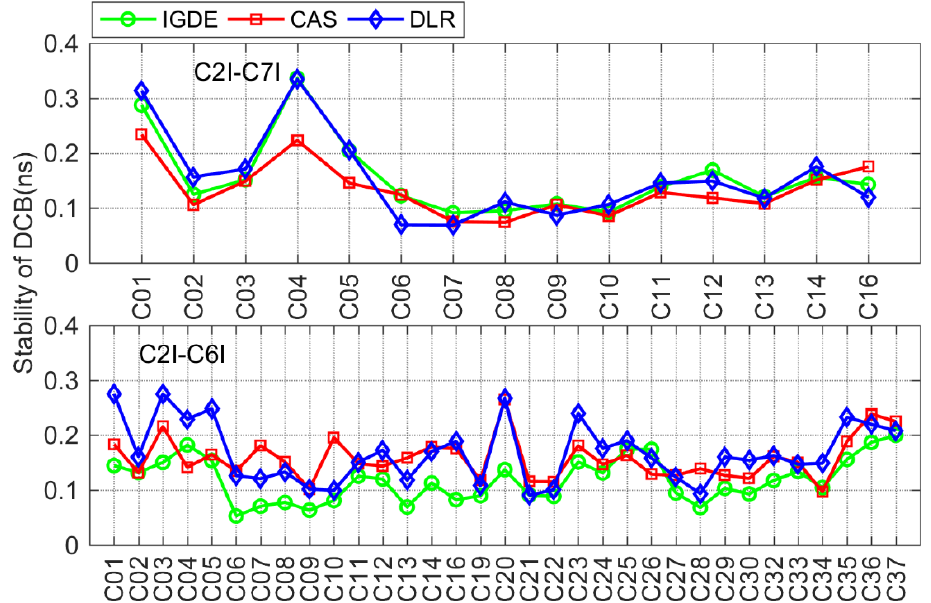
Figure 13. Stability of the GLONASS DCB obtained by IGDE, CAS, and DLR.